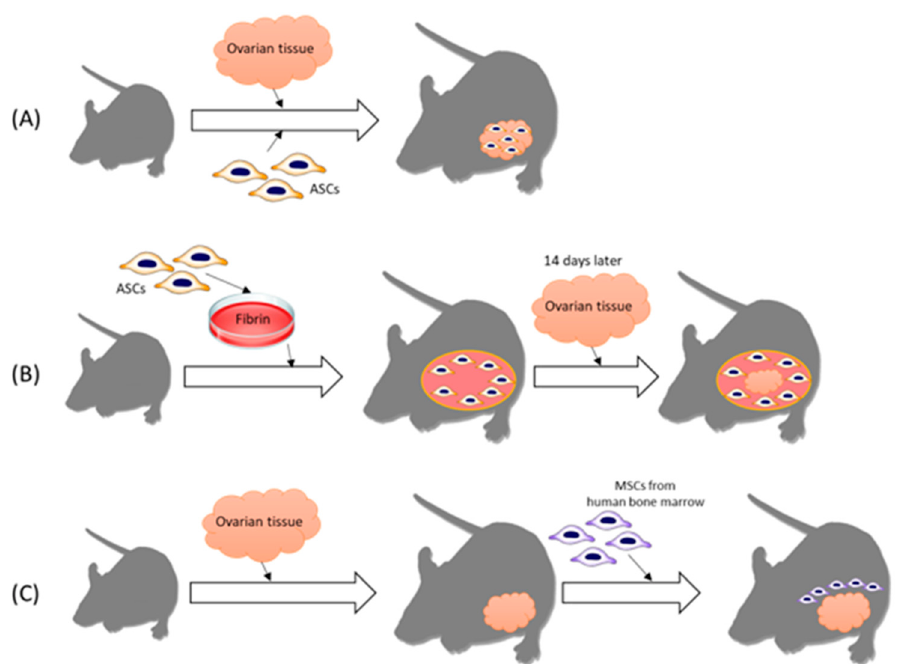
Figure 2. Several methods for utilizing human stem cells for ovarian tissue transplantation. ( A ) Ovarian tissue was implanted on the retroperitoneum of the abdomen. Then ASCs were injected directly into the center of the transplanted ovarian tissue. ( B ) Fibrin scaffold was prepared with ASCs and implanted on the inner peritoneal surface of the mouse. Fourteen days later, ovarian tissue was placed between the fibrin and peritoneum. Increased oxygenation around implanted ovarian tissue was seen. ( C ) Ovarian tissue was implanted into the subcutaneous area of the abdomen. MSCs obtained from human bone marrow were placed under the graft with growth factor-reduced Matrigel. MSCs may help neovascularization and blood perfusion of transplanted grafts. ASC, adipose tissue-derived stem cell; MSC, mesenchymal stem cell .